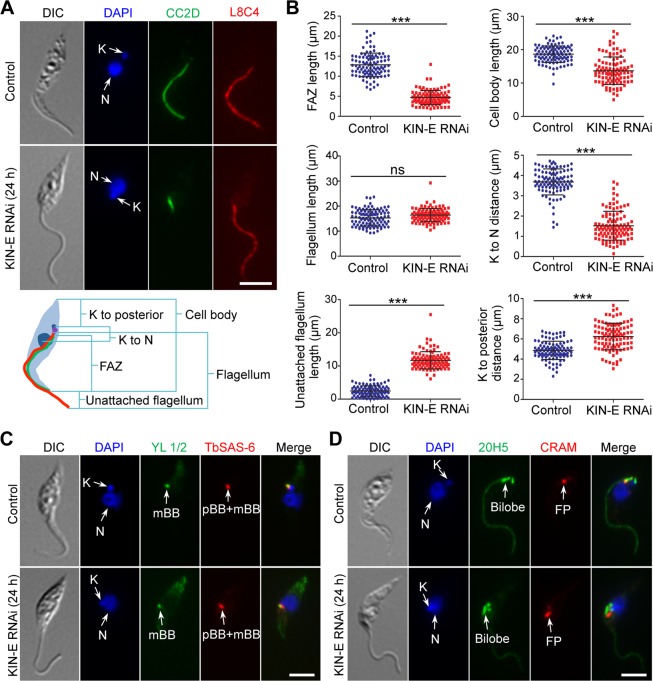
Morphological analysis of the epimastigote-like cells generated by KIN-E RNAi.(A). Morphology of 1N1K cells from control and KIN-E RNAi cells. 1N1K cells from the control and KIN-E RNAi-induced population were co-immunostained with anti-CC2D antibody to label the FAZ filament and with anti-PFR2 (L8C4) antibody to label the flagellum. Cells were counterstained with DAPI for nuclear (N) and kinetoplast (K) DNA. The cartoon depicted a 1N1K cell used for measuring the length of cell body, flagellum, unattached flagellum, FAZ filament, kinetoplast (K) to posterior cell tip, and kinetoplast to nucleus (N). Scale bar: 5 μm. (B). Morphometric measurement of uninduced control cells and KIN-E RNAi-induced (24 h) cells. 1N1K cells from control and KIN-E RNAi cells (+Tet, 24 h) were immunostained with anti-CC2D and anti-PFR2 antibodies, and the length of the cell body, the FAZ, the flagellum, the unattached flagellum, kinetoplast to nucleus, and kinetoplast to the posterior tip were measured and plotted (n = 101 for control cells and n = 104 for RNAi cells). ***, p<0.001; ns, no statistical significance. (C). Position of the flagellar basal body in control and KIN-E RNAi cells. Cells (1N1K) were co-immunostained with YL 1/2 antibody to label the mature basal body (mBB) and with anti-TbSAS-6 antibody to label both the mBB and the pro-basal body (pBB), and then counterstained with DAPI for nuclear and kinetoplast DNA. Scale bar: 5 μm. (D). Positions of the bilobed structure and flagellar pocket in control and KIN-E RNAi cells. Cells (1N1K) were co-immunostained with 20H5 antibody to label the bilobed structure and with anti-CRAM antibody to label the flagellar pocket (FP), and then counterstained with DAPI for nuclear and kinetoplast DNA. Scale bar: 5 μm.